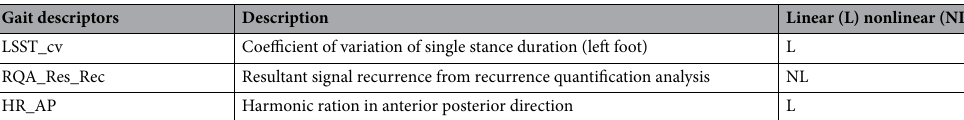
Table 5. List of 58 linear and nonlinear gait variability descriptors used in fall classification.